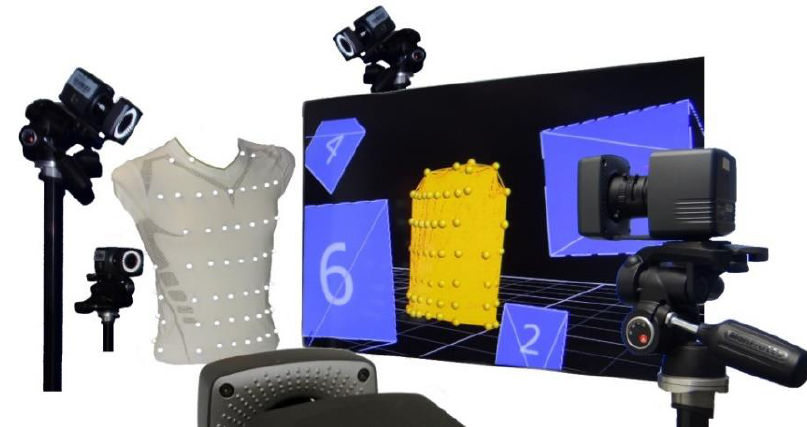
Figure 1. Schematic sketch of the MoCap system.